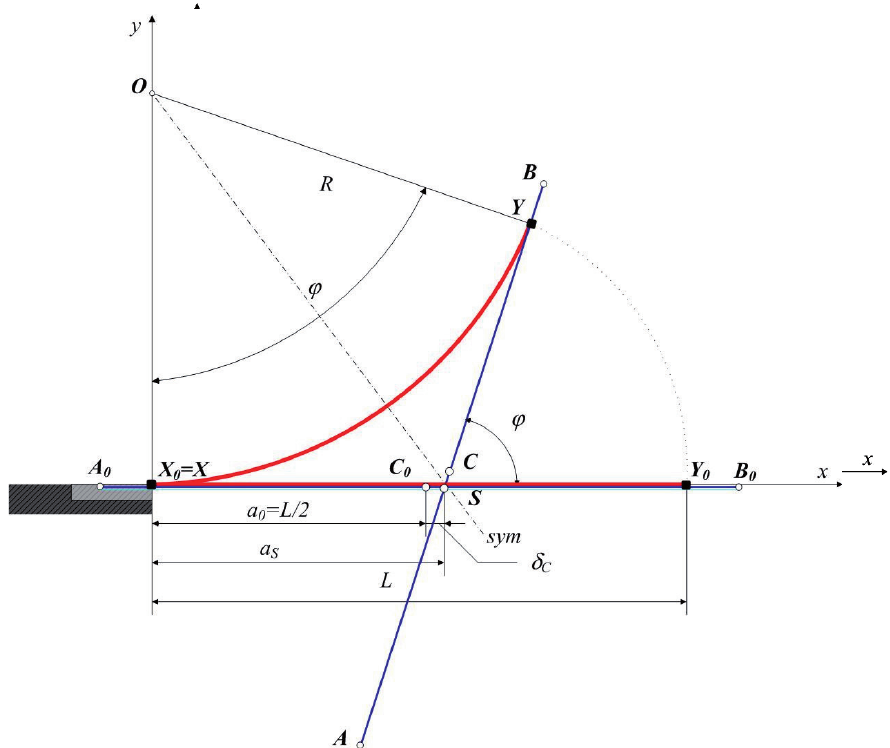
Fig. 5. Geometrical model of the